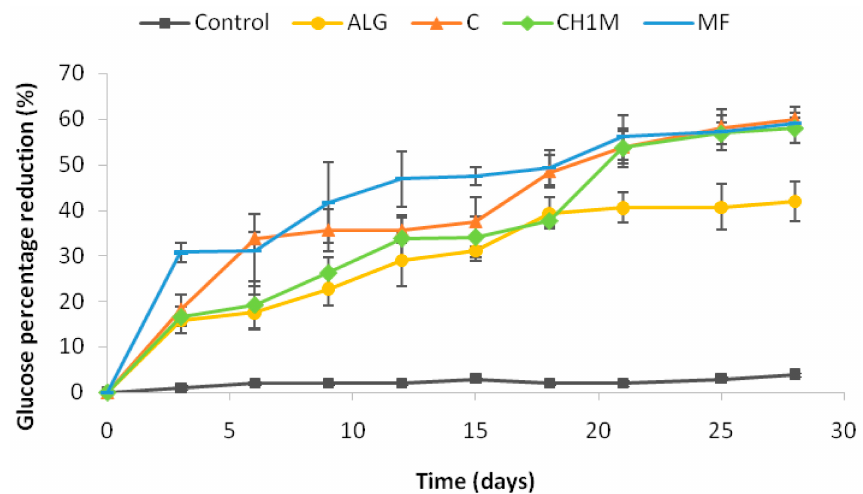
Figure 5. Percentage reduction in blood glucose level in rats treated with carboxymethyl cellulose sodium salt (Control), microparticles placebo (ALG), non cross-linked microparticles formulation C, cross-linked microparticles formulation CH1M and commercially available tablet with metformin hydrochloride (MF) after 28 days treatment ( n = 6).